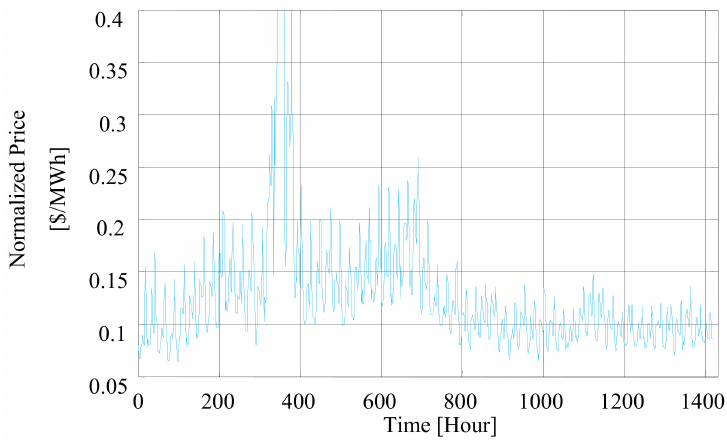
Figure 15. Changes in normalized price signals of NYISO.